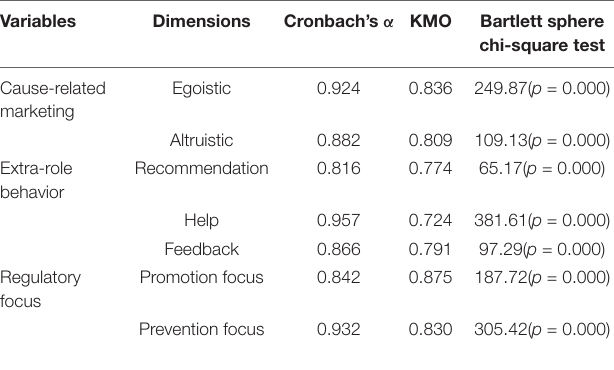
TABLE 1 | Reliability and validity test